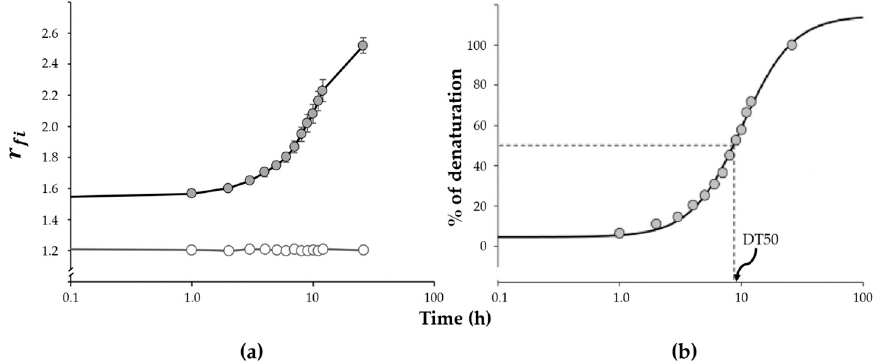
Figure 2. Effect of urea on the denaturation of HDL ‐ apolipoproteins. ( a ) The fluorescence in healthy subjects ( n = 6) was monitored as described in Figure 1: without urea (open circles) or 8 M urea activity (gray circles) and represented as r fi (see the text for details). ( b ) Data set were adjusted to (cid:4673) using the SigmaPlot software in order to define the mean time at a sigmoid curve (cid:4672)𝑦 (cid:3404) (cid:2869) (cid:2869)(cid:2878)(cid:3032) (cid:3127)(cid:3299) which 50% of the HDL ‐ proteins were denatured (DT50), establishing that the value of the 𝑟 (cid:3033)(cid:3036) at basal conditions (t = 0 h) was equivalent to 0% of denaturation and the ratio after 26 h of incubation with urea 8 M represented 100% of denaturation.